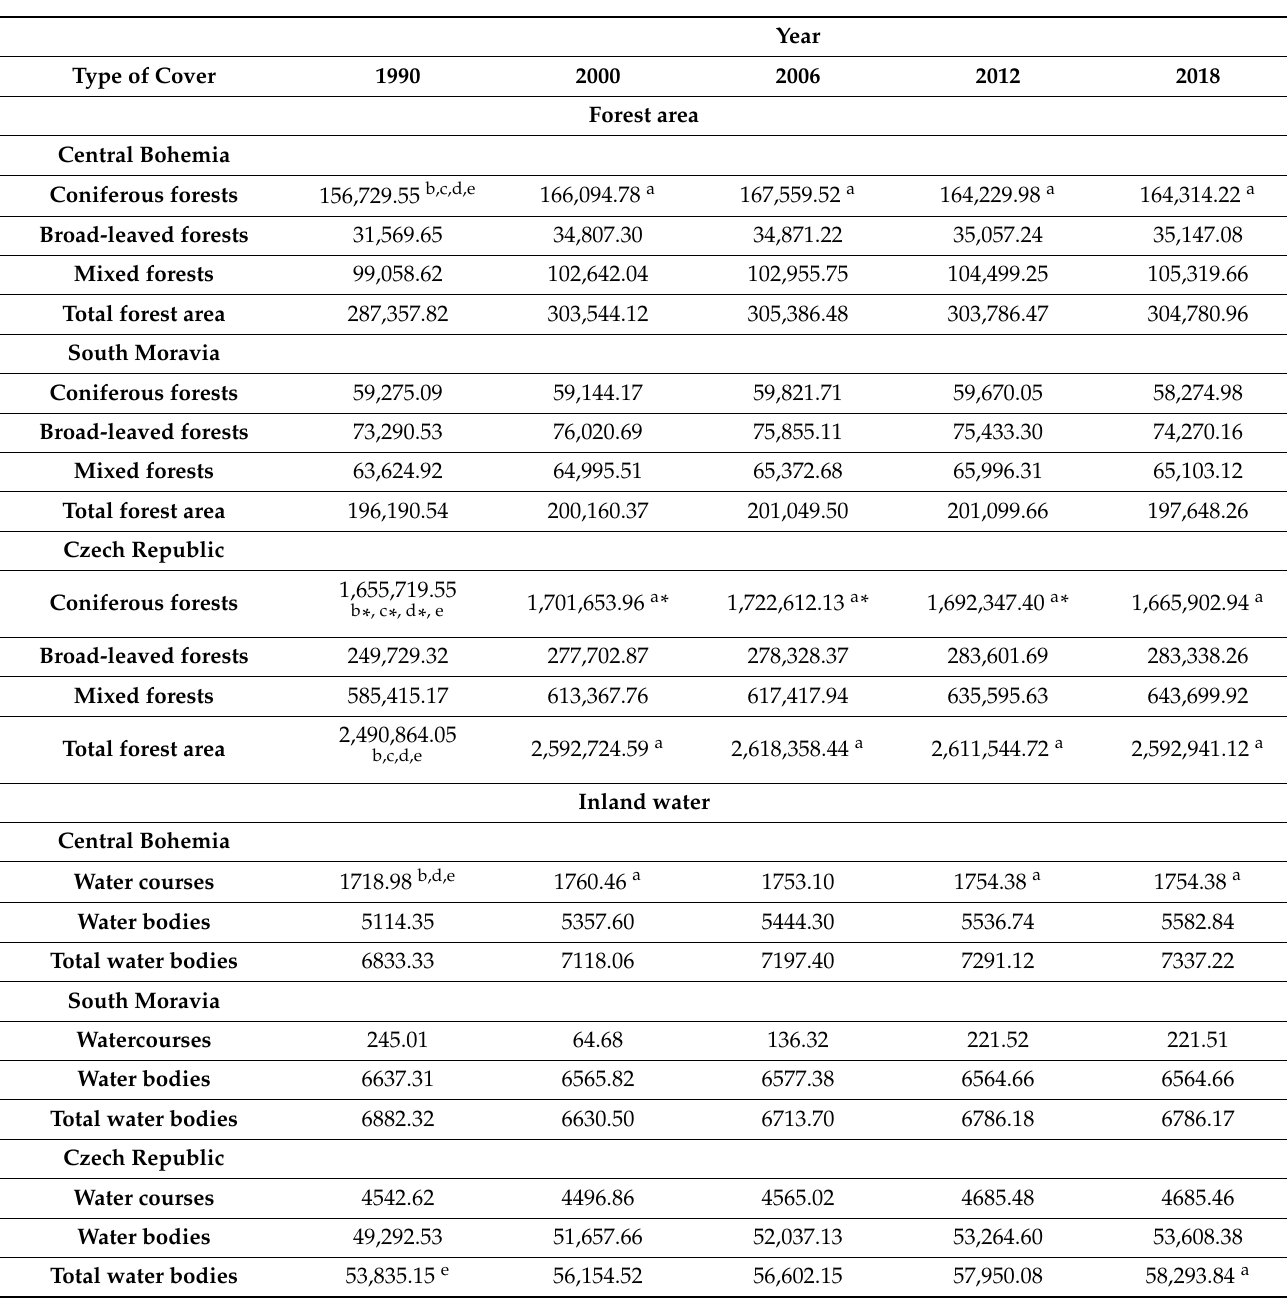
Table 2. Land cover changes in the Czech Republic in 1990, 2000, 2006, 2012, and 2018 (in ha), by type of forest and inland water, based on the CLC database, processed, and calculated by the authors